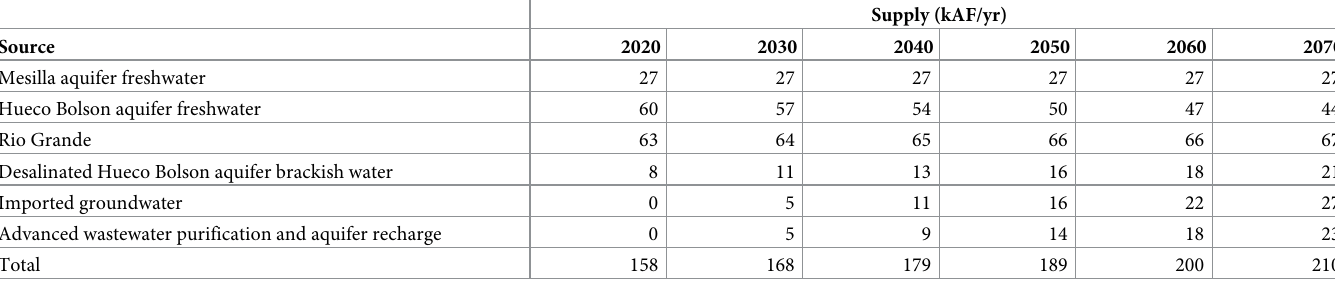
Table 1. Annual water supplies by source from 2016 Far West Texas Water Plan [28]. kAF = thousands of acre feet per year.